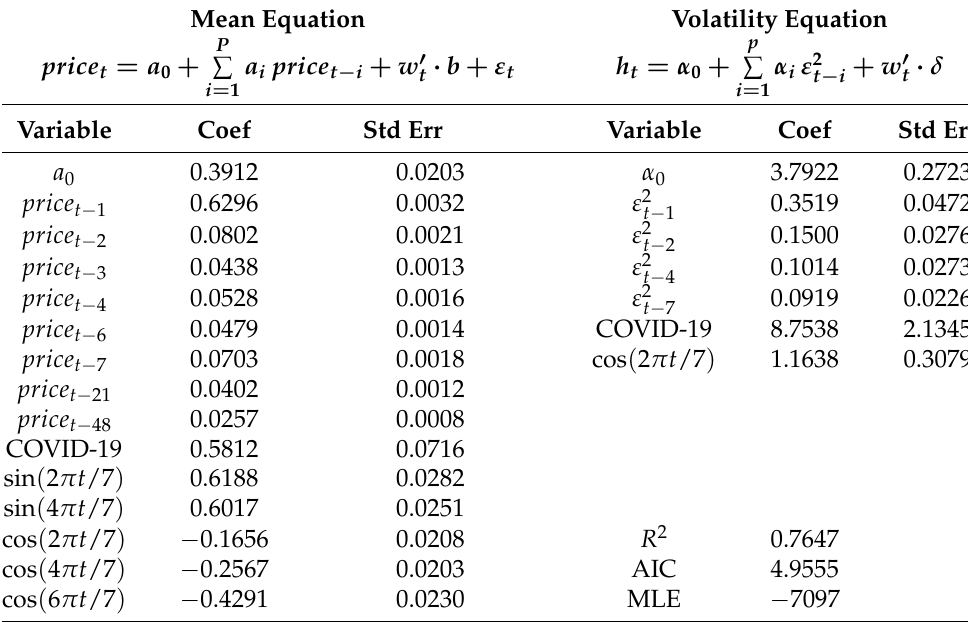
Table 1. Estimation results when assuming SGED for standardized residuals.